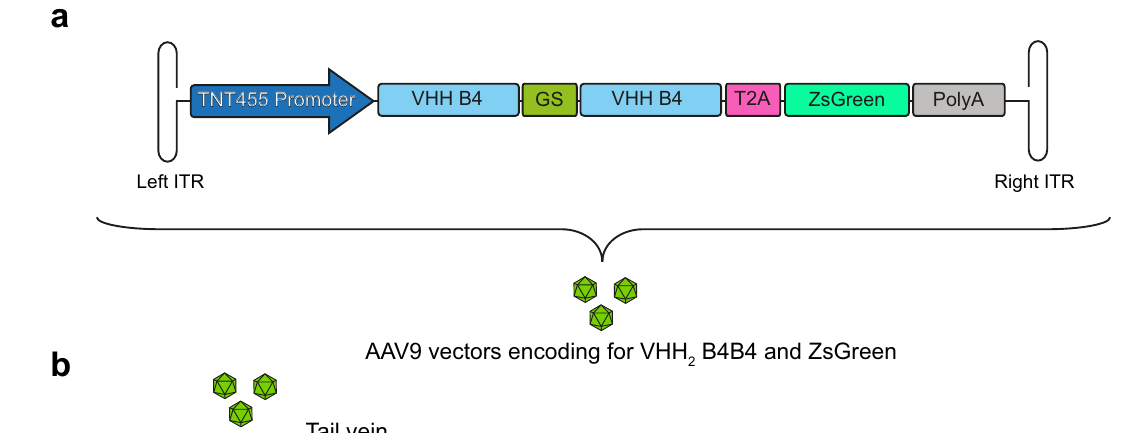
protein, including PLN pentamers and phosphorylated states of the protein. Our approach resulted in the successful isolation of PLN binders that can also distinguish between phosphorylated and non-phosphorylated forms of PLN, which was all achieved in vitro using peptide-based selections for binding. Further- more, with the bivalent VHH 2 B4B4 variant, we were able to